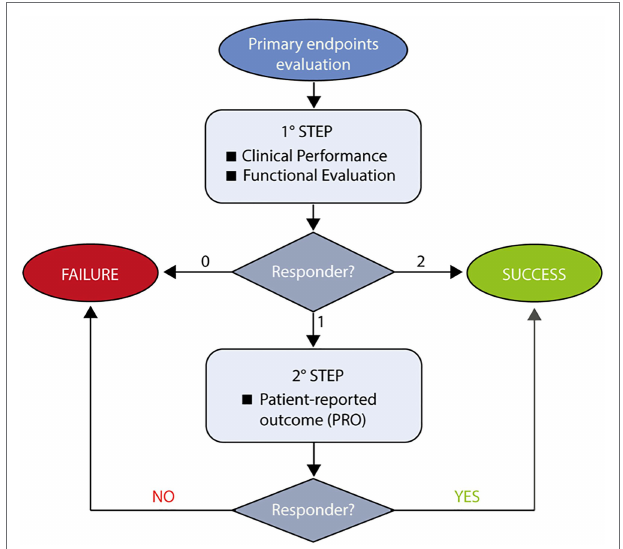
FIGURE 2 | Flowchart describing assessment of Hologene 5 efficacy. The evaluation of Hologene 5 efficacy is the primary endpoint of this clinical